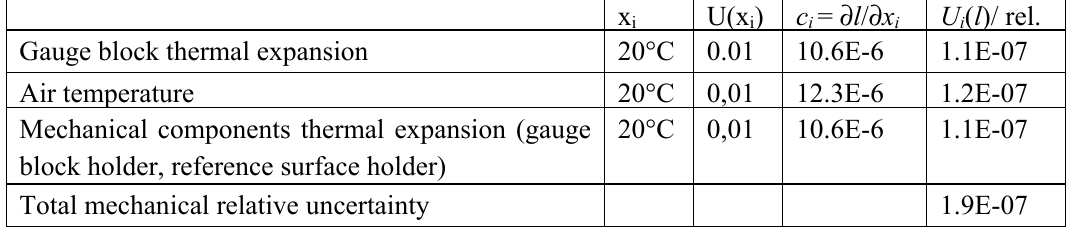
Table 2. Uncertainty part given by mechanical parameters of the experimental